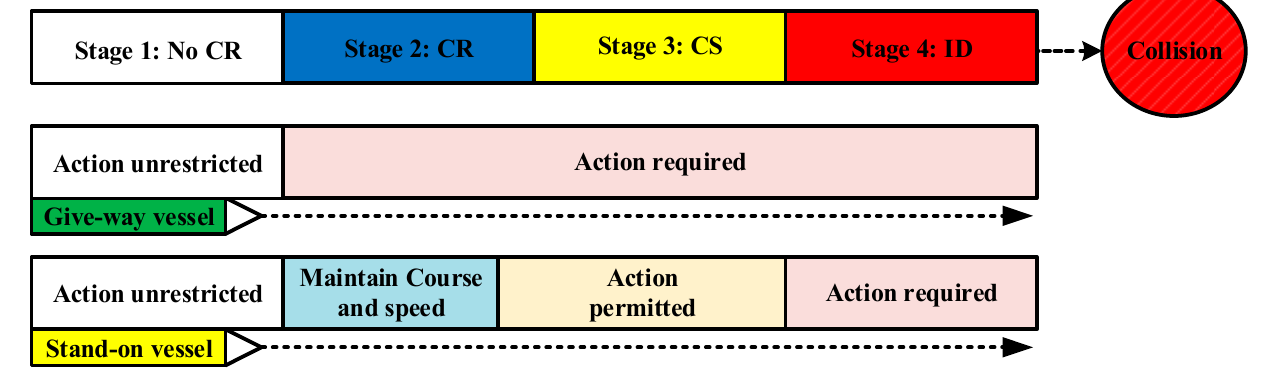
Figure 1. Stages and collision-avoidance actions that should be taken by two vessels. The four stages are divided into (1) no risk of collision, (2) risk of collision, (3) close-quarter situation and (4) immediate danger stage, and are displayed in white, blue, yellow and red colors, respectively.